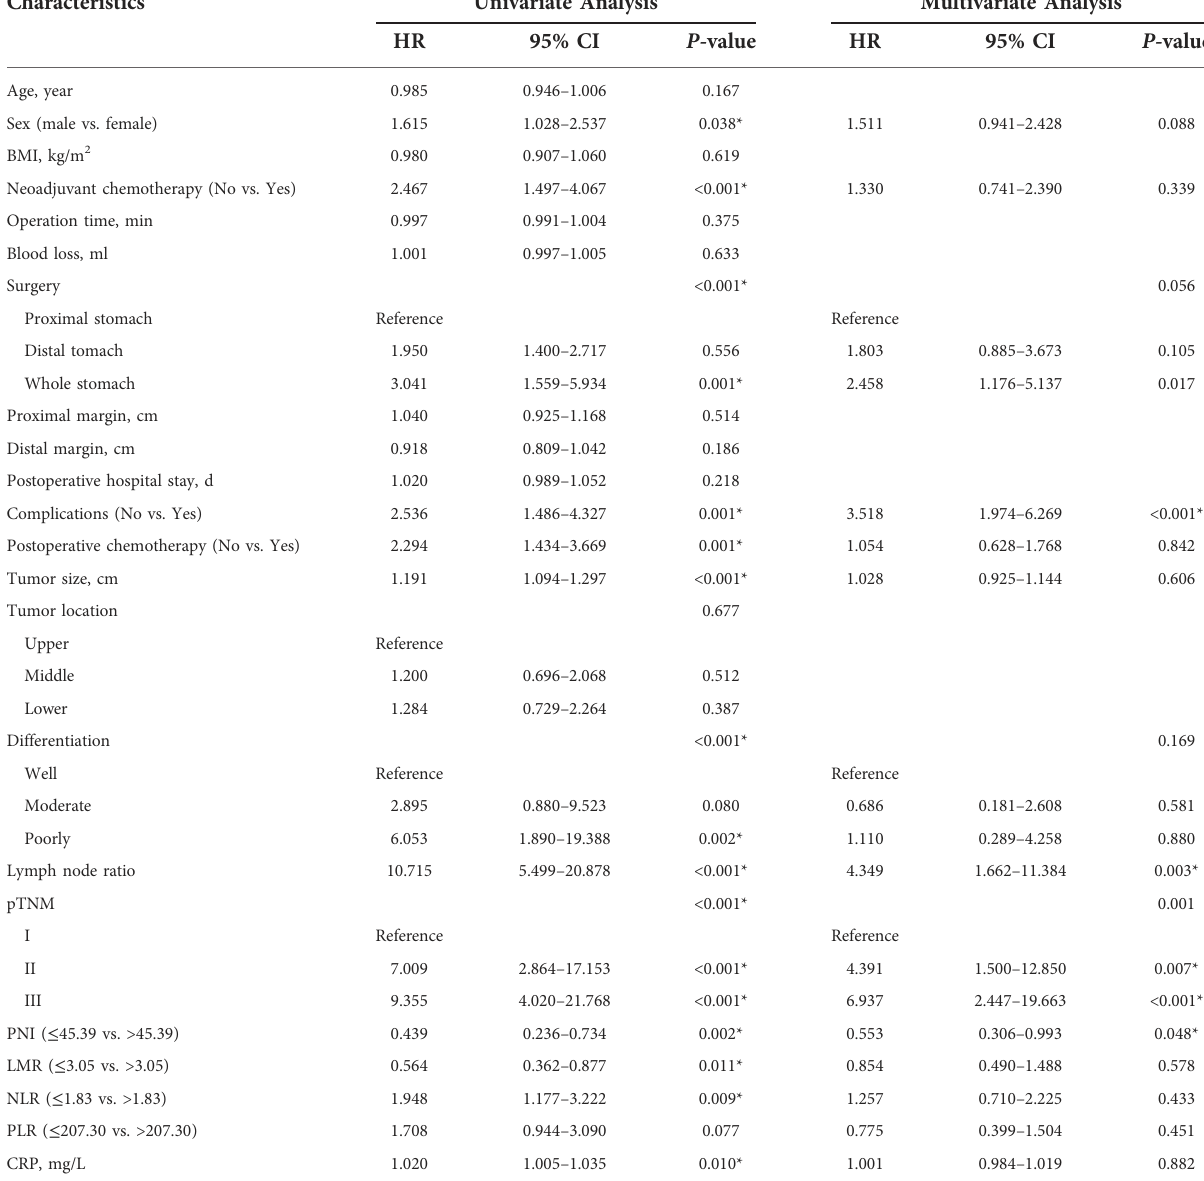
TABLE 2 Univariate and multivariate analysis of overall survival of patients undergoing RRG in the training set.